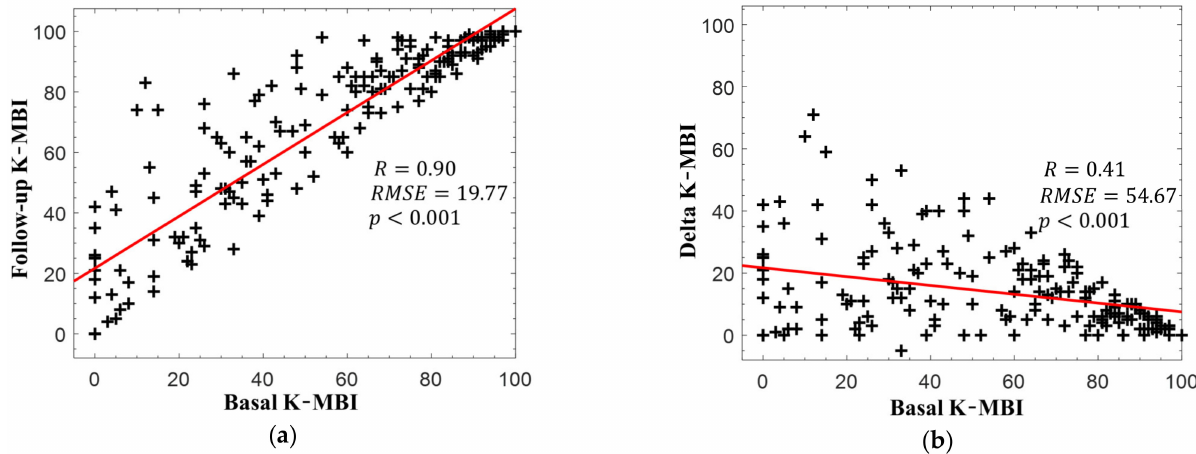
Figure 2. ( a ) Korean version of the modified Barthel index (K-MBI) scores at basal and follow-up examinations and ( b ) changes in K-MBI scores according to initial K-MBI scores. The red lines indicate the linear regression